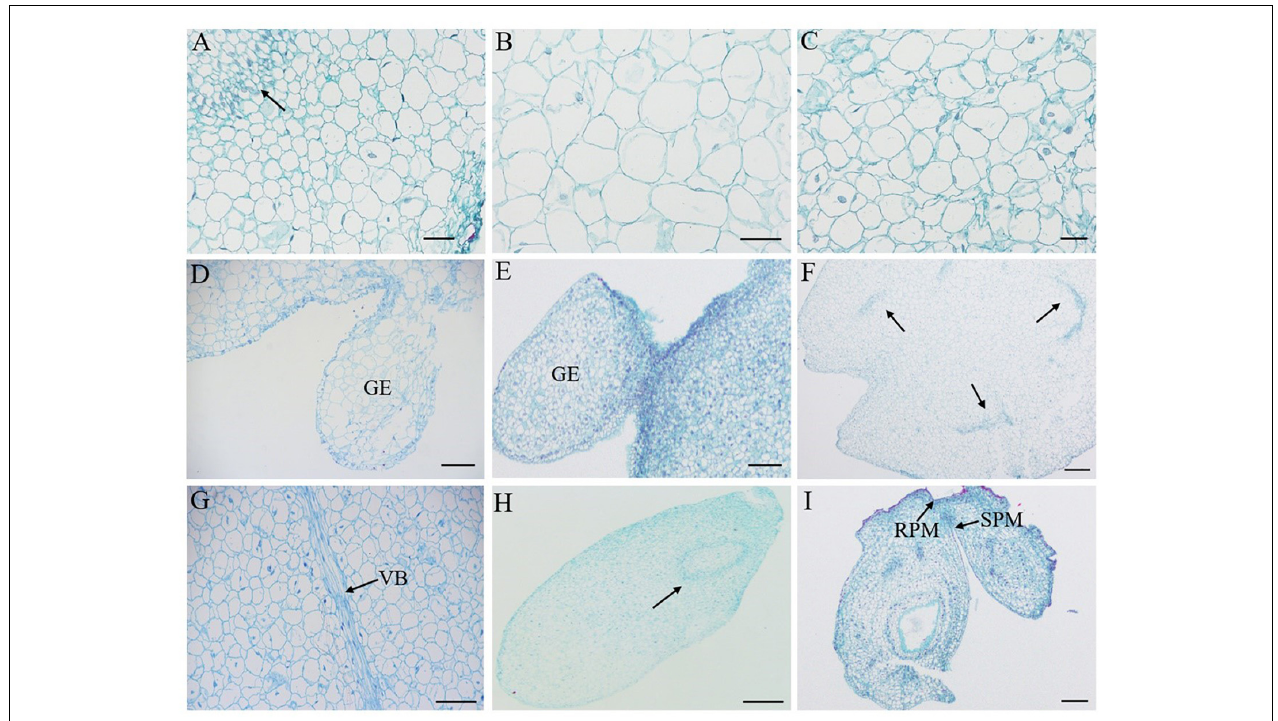
FIGURE 5 | Histology observation of direct and indirect somatic embryogenesis from cotyledons of C. oleifera. (A) Embryogenic formation and aggregation 40 days after inoculation (arrow). (B) Non-embryogenic calli 50 days after inoculation. (C) Embryogenic calli at 50 days after inoculation. (D) Globular embryo at 70 days after inoculation in indirect somatic embryogenesis. (E) Globular embryo at 50 days after inoculation in direct somatic embryogenesis. (F,G) Transitional from globular to cotyledonary embryo with well-differentiated vascular bundle (VB) of somatic embryo (arrow). (H) Torpedo embryo with closed vascular bundle 80 days after inoculation. (I) Mature cotyledonary embryo with root and shoot pole meristems (RPM, SPM) 85 days after inoculation. Bars: (A–C) = 40 µ m, (D,G) = 100 µ m, and (E,F,H,I) = 200 µ m.